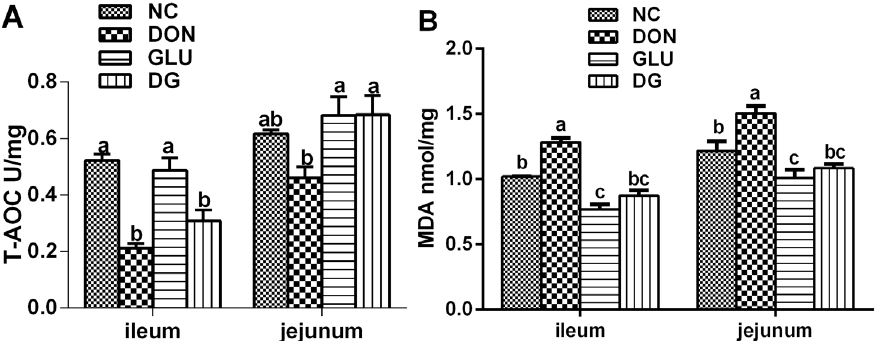
Figure 3. Ileum and jejunum anti-oxidative capacity in each group. A: T-AOC of ileum and jejunum in each group. B: MDA concentrations of ileum and jejunum in each group. Dietary treatments were NC, an uncontaminated basal diet, DON, the basal contaminated with 4 mg/kg deoxynivalenol, GLU, uncontaminated basal diet with 2% (g/g) glutamic acid supplementation, and DG, deoxynivalenol-contaminated (4 mg/kg) basal diet with 2% glutamic acid supplementation. Data are presented as means 6 SEM, n=7, with a–c used to indicate a statistically significant difference (P , 0.05, one way ANOVA method). MDA: methane dicarboxylic aldehyde (nmol/ml); T-AOC: total antioxidant capacity (U/mg).